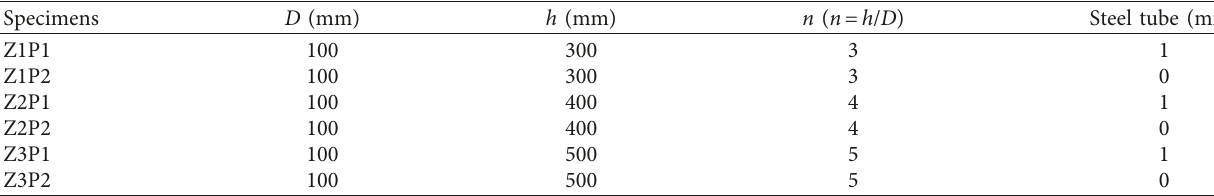
Table 5: List of columns for CFST columns with foundation.